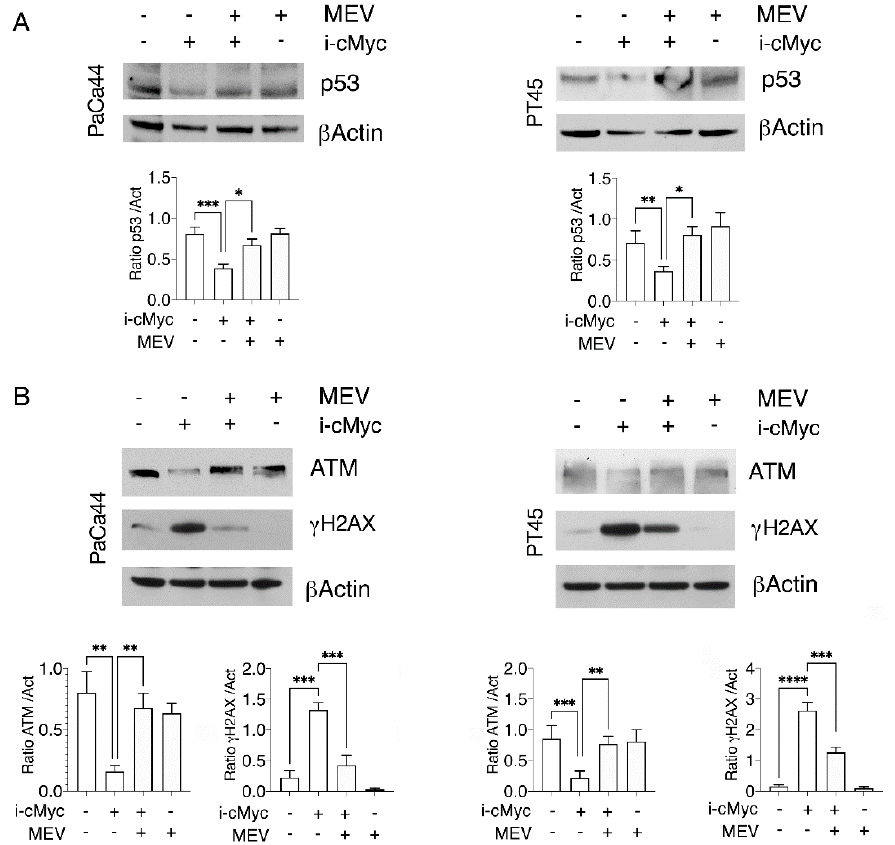
Figure 5. Mevalonate supplementation is able to restore mutp53 expression and to prevent DNA damage in pancreatic cancer cells undergoing c-Myc inhibition. PaCa44 and PT45 cells were treated with cMyc inhibitor (i-cMyc) (50 µ M) or MEV (20 µ M) or with both for 48 h to evaluate p53 ( A ), ATM and γ H2AX ( B ) expression by Western blot analyses. β Actin was used as loading control and one representative experiment is shown. The histograms represent the mean ± SD of densitometric analysis of the ratio of p53/Act, ATM/Act and γ H2AX /Act; p value: * <0.05; ** <0.01; *** <0.001; **** <0.0001.